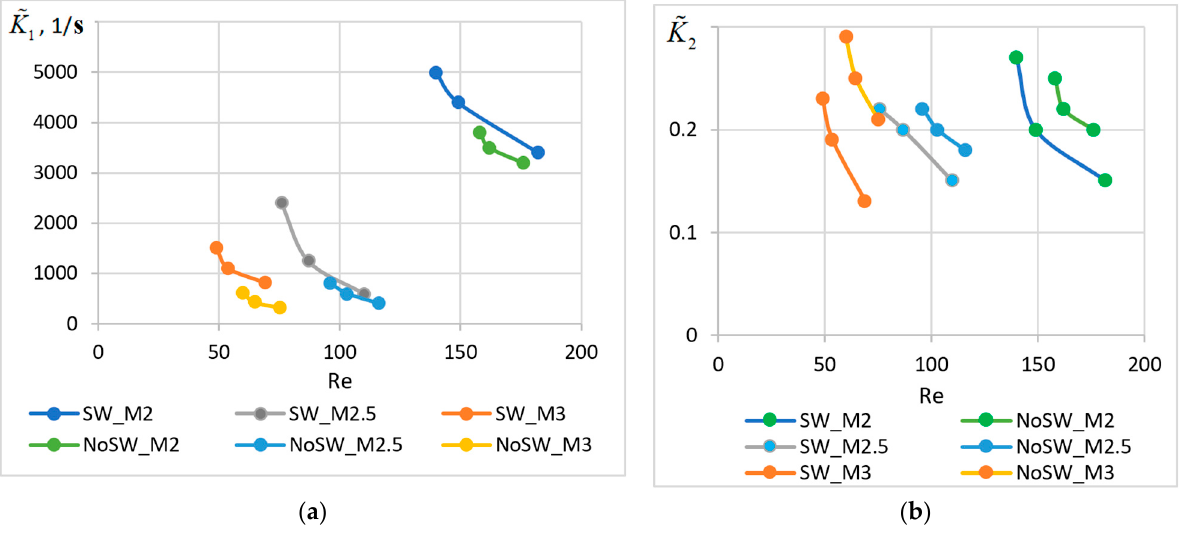
~ К ( b ) on Re. Figure 8. Dependence of coefficients (cid:101) K K  ( a ) and ~ 1 ( a ) and (cid:101) K 2 ( b ) on 2 1 К ( b ) on Re. K  ( a ) and 2 1